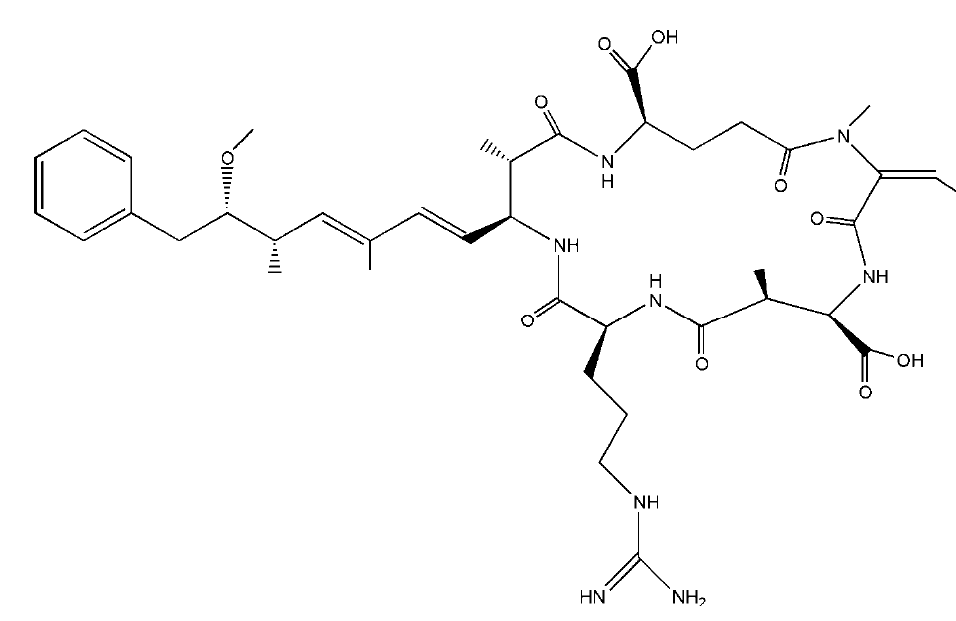
Figure 1. Structure of